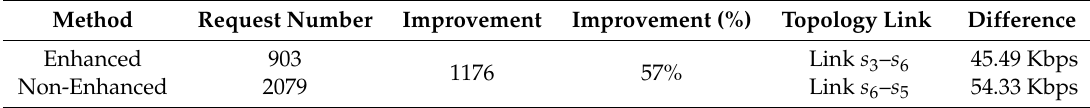
Table 3. Summary of Enhanced vs. Non-Enhanced Methods for Data Rate in Study Case